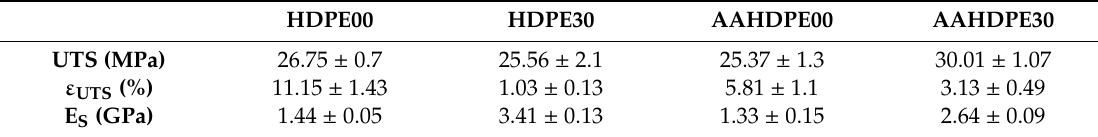
Figure 7. Strain–stress curves for HDPE00, HDPE30, AAHDPE00 and AAHDPE30. The average ultimate tensile stress and its corresponding strain are plotted for all the compounds. Table 6. Average and standard deviation of the ultimate tensile strength (UTS), strain at UTS ( ε UTS ) and secant modulus (E S ) values for the HDPE00, HDPE30, AAHDPE00 and